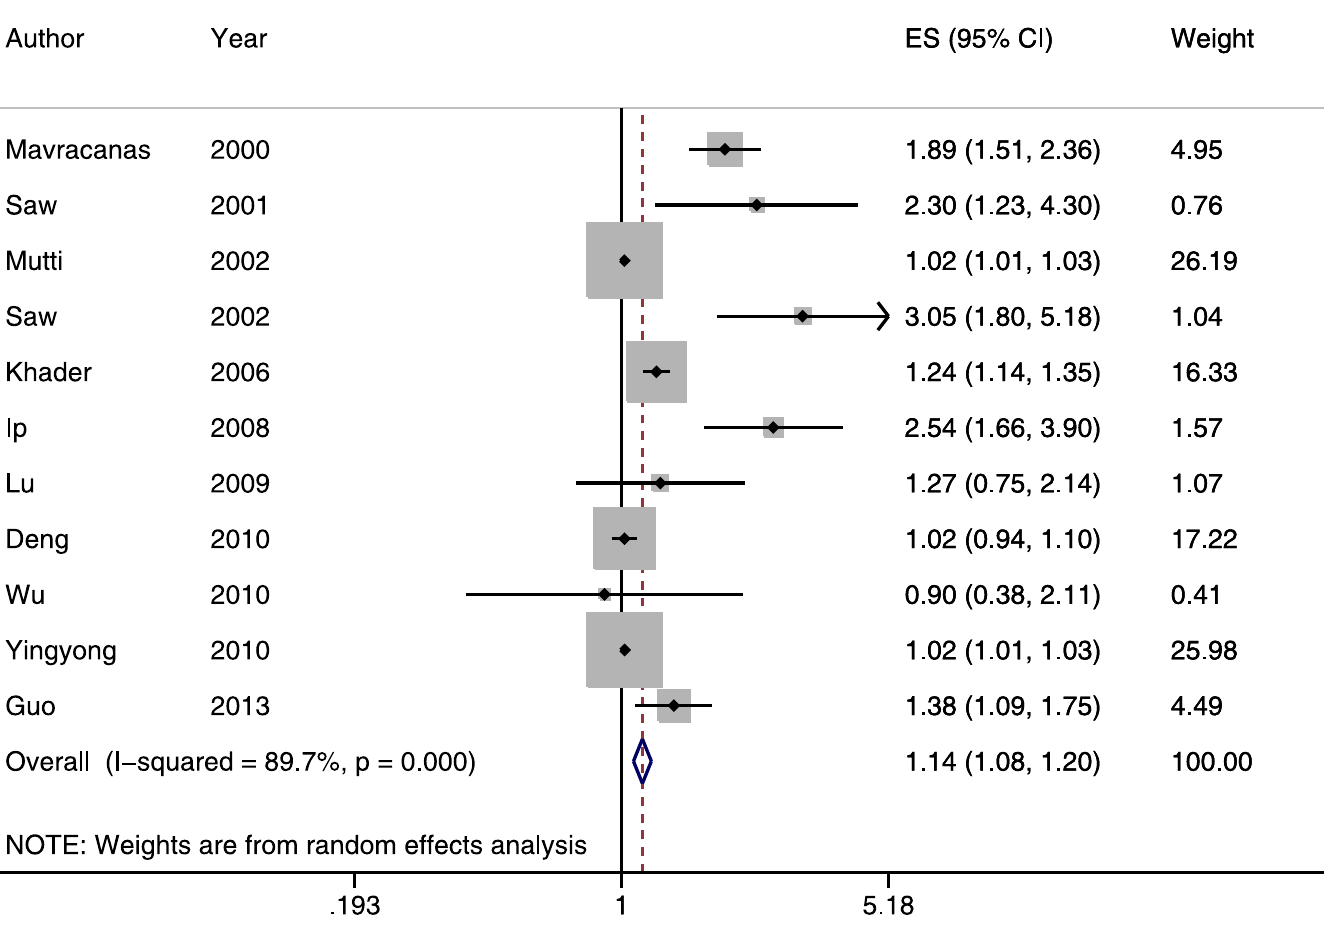
Fig 2. Forest plot of studies reporting an association between near work and prevalence of myopia (odds ratio). A pooled odds ratio of 1.14 (95% CI: 1.08 – 1.20) suggested that near work was associated with myopia.